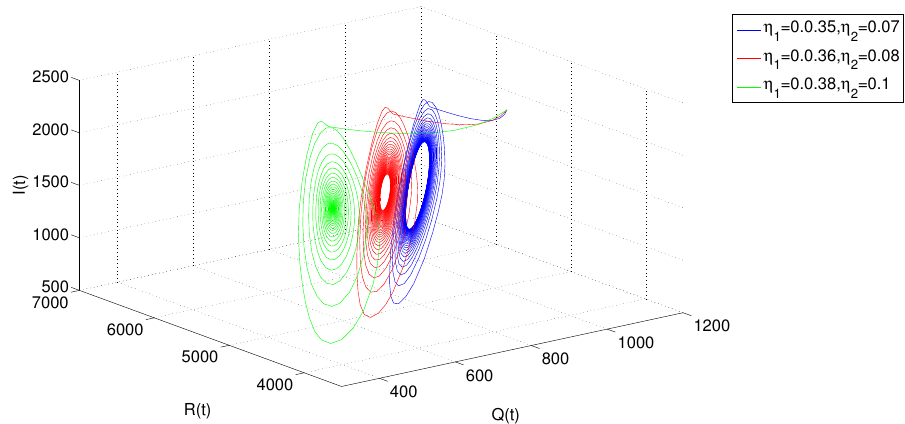
Figure 5. Dynamic behavior of system (22): projection on I-Q-R for different η 1 and η 2 at τ = 13.75.